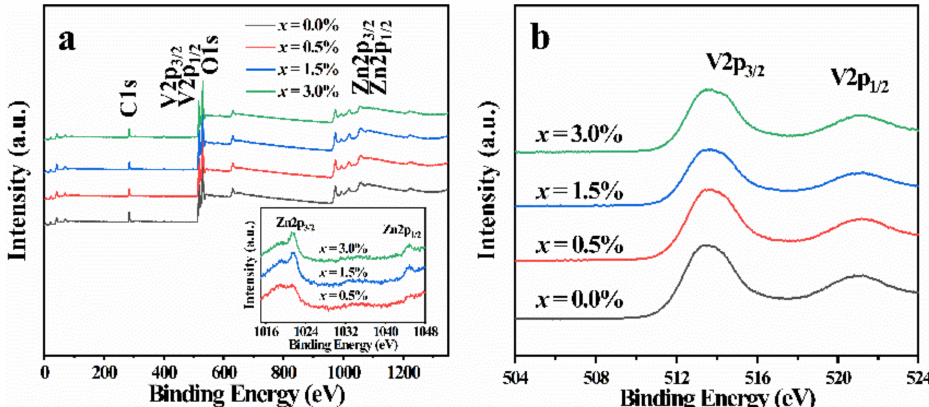
Figure 3. ( a ) X-ray photoelectron full-scan spectrum of Zn-VO 2 (B) samples, illustrations is X-ray photoelectron spectra of Zn 2p 3/2 and Zn 2p 1/2 ; ( b ) X-ray photoelectron spectra of V 2p 3/2 and V 2p 1/2 .